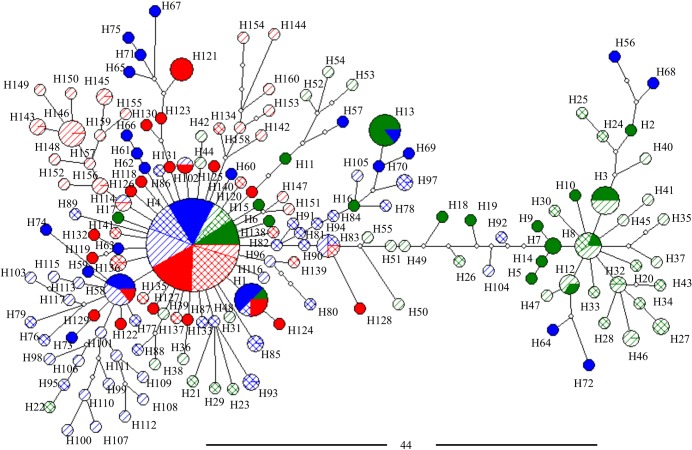
Genealogical relationship among 160 haplotypes of Colombian Ae. aegypti based on Median Joining haplotype network of combined COI-ND4 genes.The size of the nodes corresponds to the frequency of the haplotypes; white nodes represent median vectors (hypothetical haplotypes). The black bar represents the number of mutational steps (44 steps) between the nodes of group 1 (left) and group 2 (right). Color indicates the collection origin: BE (green), RI (blue) and VI (red), and respective fill color, crossbars and diagonal lines represent A, B, and C samplings, respectively (see Table 1 for details).